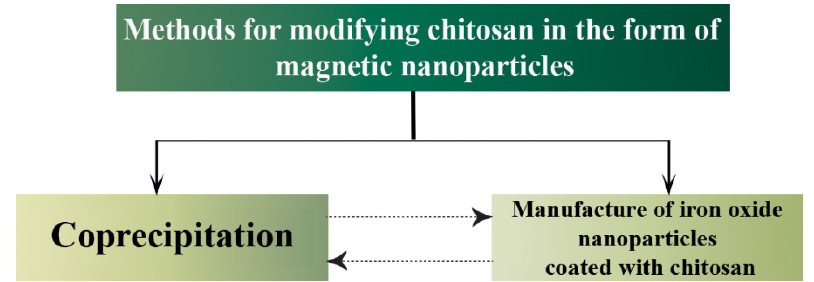
Figure 5. A well-known method of modifying chitosan to form magnetic NPs.